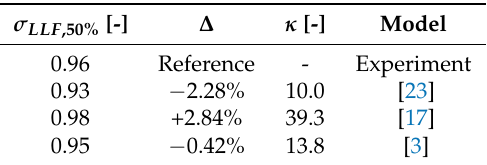
Table 5. Comparison of the normalized fatigue strength resulting from different Weibull parameters κ using a return period of α = 1.98 (specimen B in this